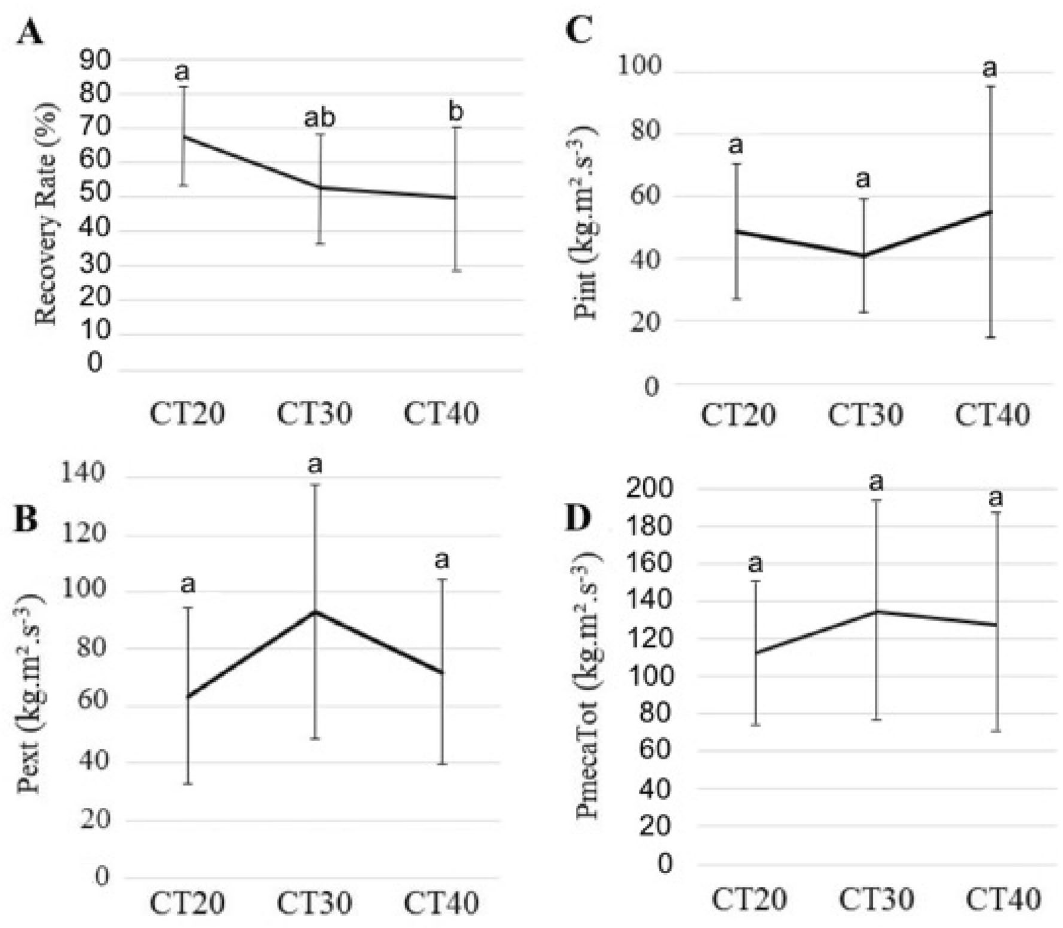
Figure 3. Energy recovered and powers. Mean (± SD) of the recovery rate ( A ), external power P ext ( B ), internal power P int ( C ) , and total mechanical power P mecaTot ( D ) of the system formed by the two individuals plus the box they carry (PACS) in the CT20, CT30, and CT40 conditions ( N = 9 pairs). The Recovery Rate is the percentage of energy recovered during one gait cycle by the PACS. Pext, Pint , and PmecaTot are respectively the positive external, internal, and total work per unit of time produced by the PACS. For the same variable the bars bearing different letters represent significantly different values (GLMM followed by a post-hoc test for multiple comparisons across